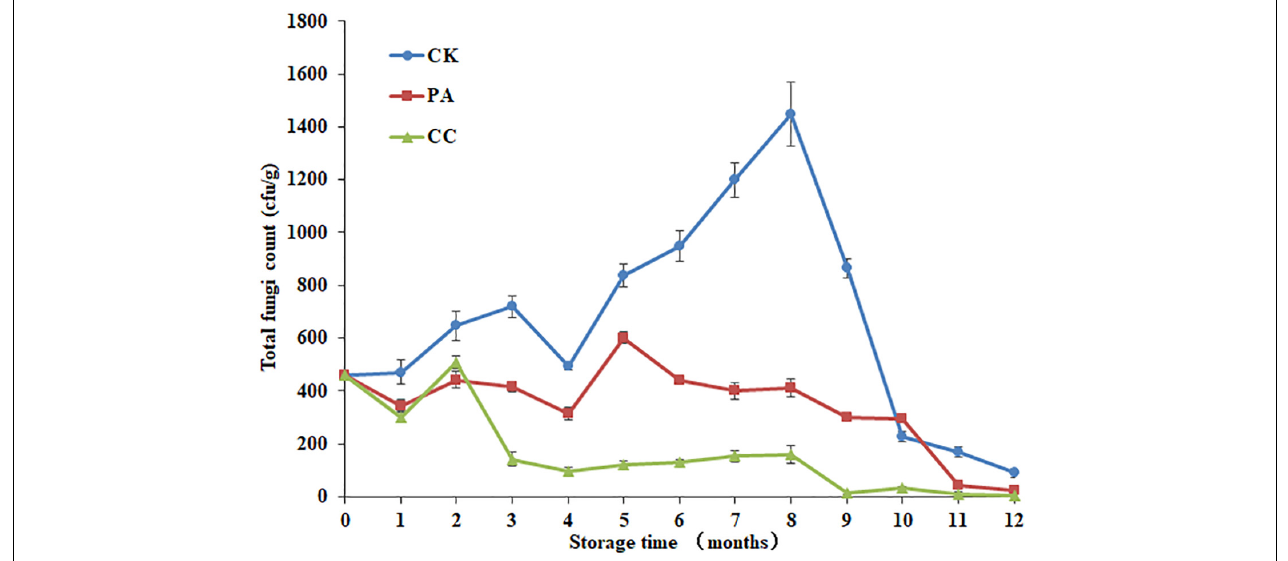
FIGURE 1 | The effect of complex essential oils on the total fungal counts in stored maize. CK, control group; PA, propionic acid treated group; CC, complex essential oils treated group. The relative standard deviation of total fungi counts is represented with bars ( n = 6).